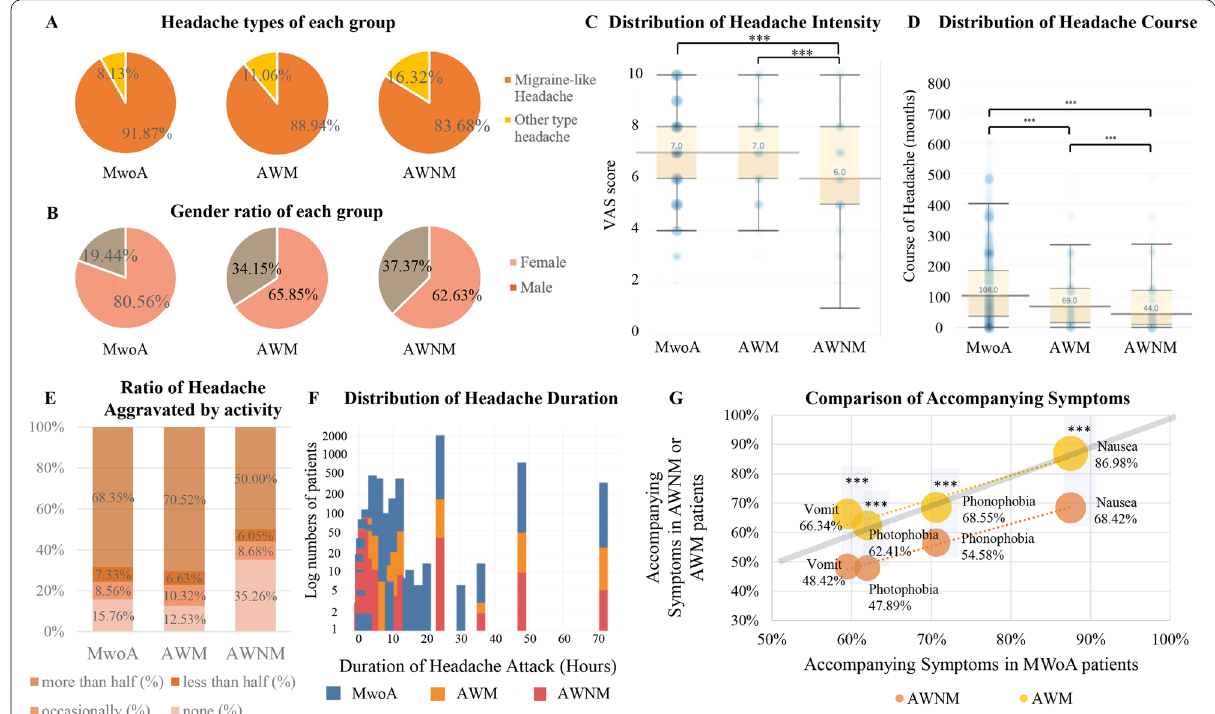
Fig. 6 Comparison of related characteristics of AWNM, AWM, and MwoA. Migraine-like headache occupied absolute majorities across all groups, and AWNM patients contributed to a much larger percentage of other headache types (16.32%) ( A ). The proportion of females was higher in MwoA than AWM and AWNM ( B ). MwoA and AWM patients had more severe headaches ( C ), longer headache course ( D ) than AWNM patients. The medians and quartiles are presented as boxplots with whiskers with a maximum 1.5 interquartile range (IQR). The circles illustrate kernel probability density, and the color depth of the circle represents the proportion of the data located therein ( C and D ). Compared to AWNM, headache attacks in MwoA and AWM patients were more likely to be aggravated by activity ( E ). The Duration of headache attacks was significantly different across all types. MwoA patients had the longest duration of headache, followed by AWM patients, and the shortest was AWNM patients (25.97 MwoA, 21.75 27.34 h in AWM, 12.14 45.53 h in AWNM). The Y-axis represents the logarithm of patient numbers with corresponding headache ± ± duration ( F ). The incidence of all accompanying symptoms in AWM patients was higher than AWNM patients with significant differences, and the incidences in AWM patients were similar to MwoA patients. The size of the circle represents the incidence of the accompanying symptoms in AWNM or AWM patients. The closer the circle is to the gray diagonal, the closer the incidence of accompanying symptoms is to MwoA patients ( G ). * p < 0.05, ** p < 0.01, *** p <